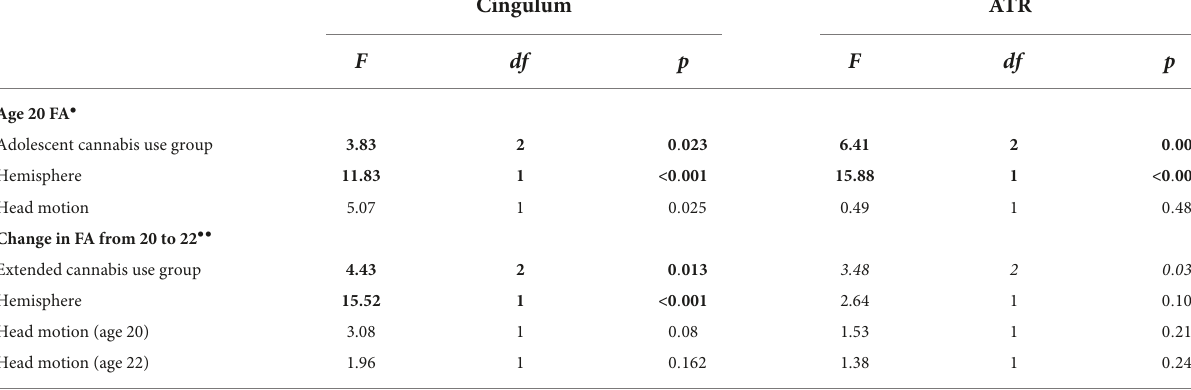
TABLE 4 Associations between cannabis use and FA of the cingulum and ATR.